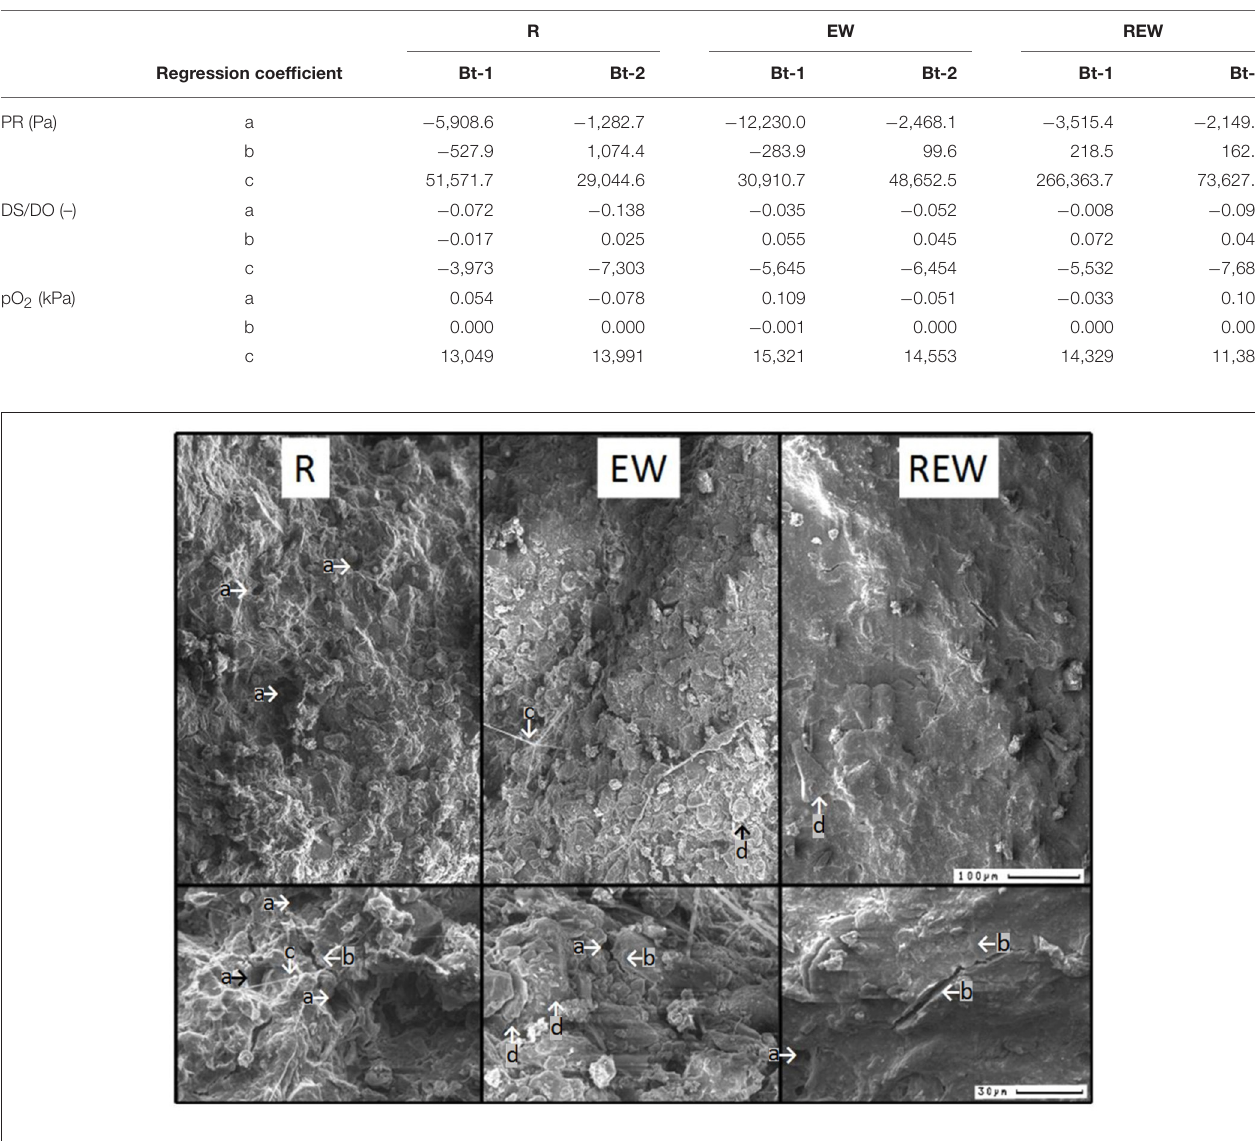
FIGURE 3 | Exemplary scanning electron microscope images of biopore walls [pore colonized by root (R), colonized by L. terrestris (EW), and (REW) just like R but followed by short-term ( < 6 months) colonization of L. terrestris ]. Using a magnification factor of 200 (upper-row) or 700 (lower row), a very porous surface for R can be observed in comparison with surfaces of EW or REW. Exemplary pores, created by lateral side roots are marked with “a,” exemplary shrinkage-induced cracks (due to root water uptake or initial shrinkage) with “b.” Fungal hyphae networks are indicated by “c.” Platy structures are clearly visible for EW